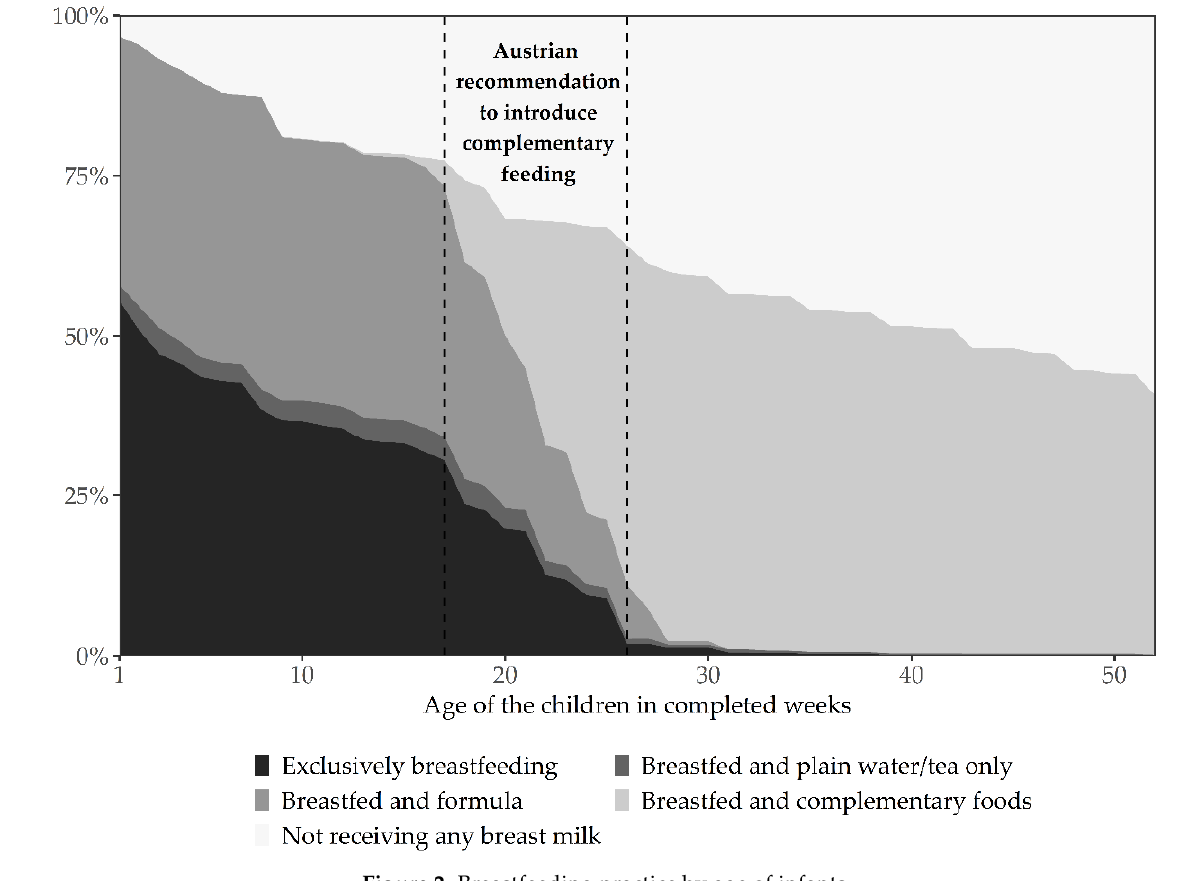
Figure 2. Breastfeeding practice by age of infants.